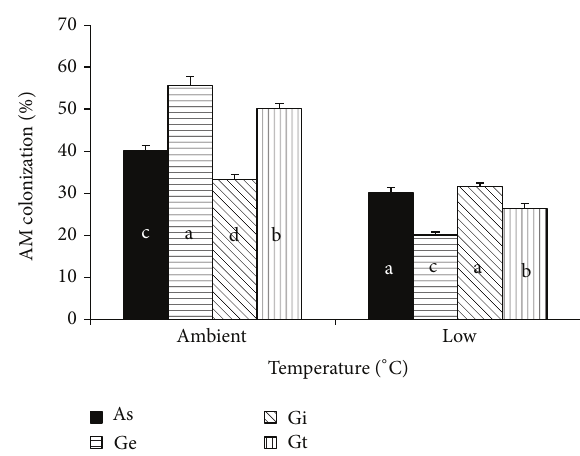
Figure 1: AM colonization of maize seedlings with different AMF strains under ambient temperature and low temperature regimes. As: Acaulospora scrobiculata ; Ge: Glomus etunicatum ; Gi: G. intraradices ; Gt: G. tortuosum . Bars represent the mean ± SE of five replicates. For each temperature, different letters on the columns indicate significant difference between the AM strains ( 𝑃 < 0.05 ) by Duncan’s